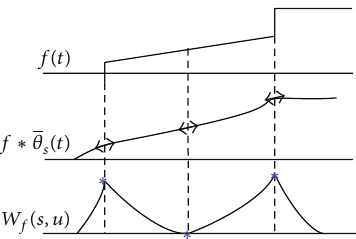
Figure 1: Signal singularities detection based on wavelet modulus